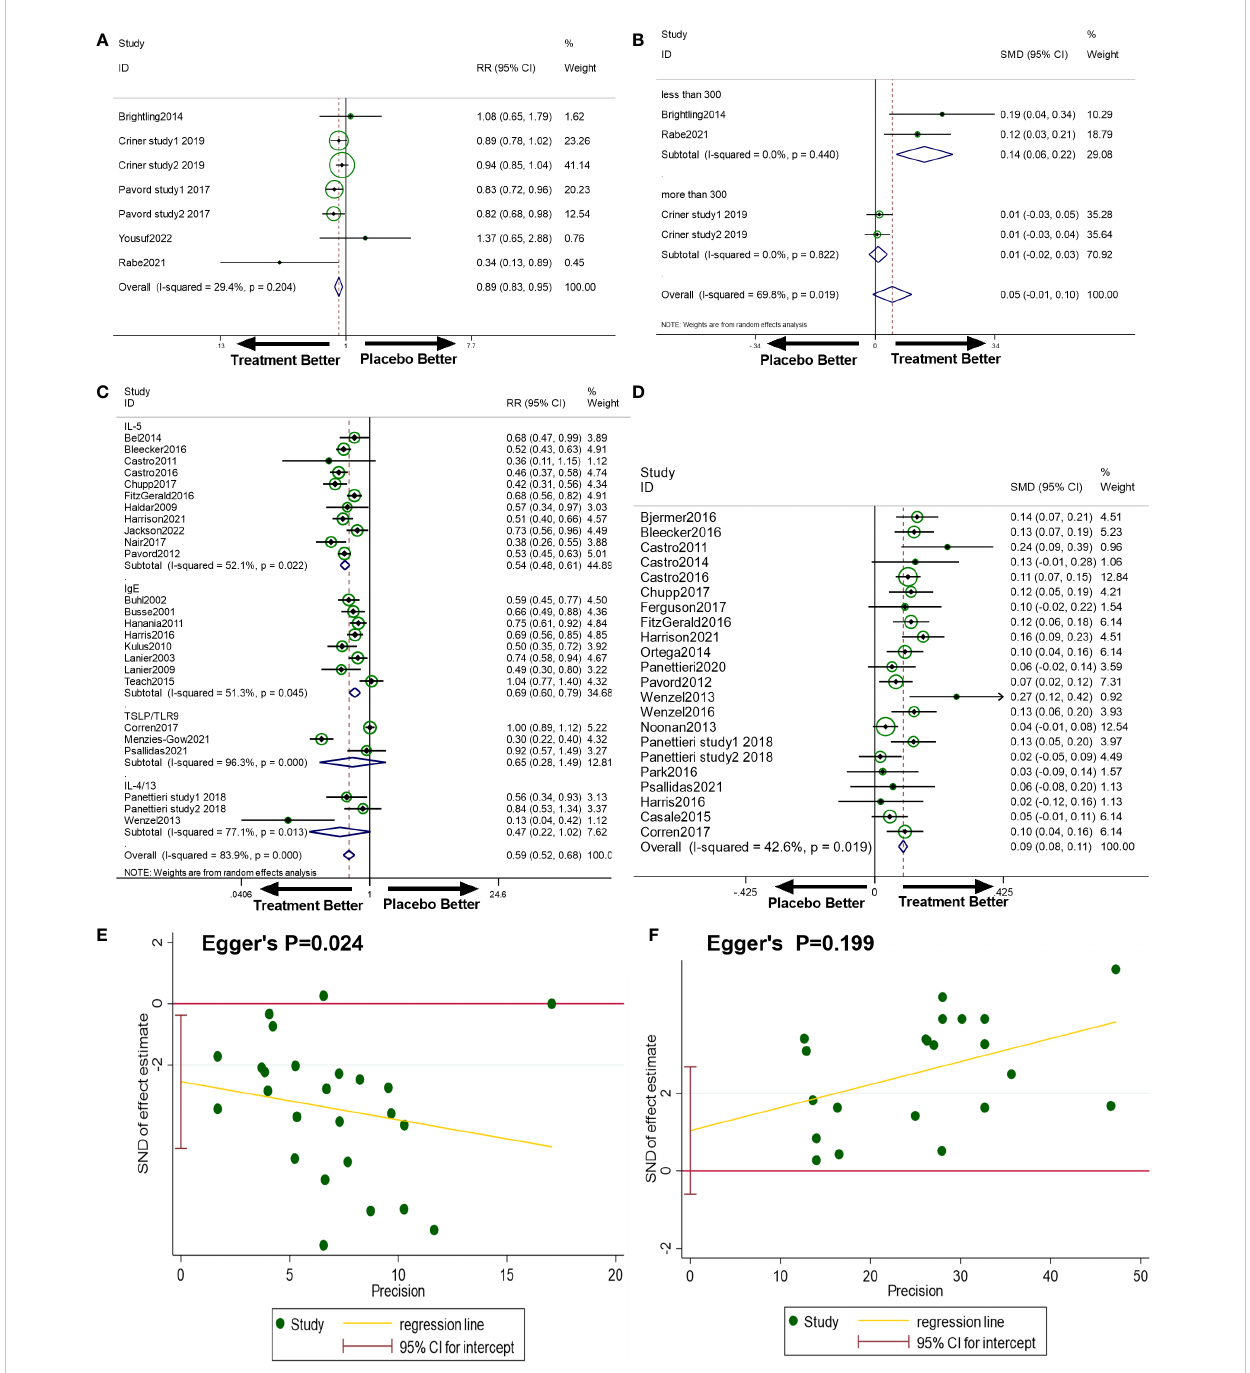
FIGURE 2 (A) The effect of anti-T2s versus placebo on exacerbation rate in COPD. Fixed-effect model. (B) The effect of anti-T2s versus placebo on FEV1 change from baseline in COPD. Random-effect model. (C) The effect of anti-T2s versus placebo on exacerbation rate in asthma. Random-effect model. (D) The effect of anti-T2s versus placebo on FEV1 change from baseline in asthma. Fixed-effect model. (E) Egger ’ s test of exacerbation rate in asthma in the meta-analysis. (F) Egger ’ s test of FEV1 in asthma in the meta-analysis. CI , con fi dence interval; SMD, standard mean difference; RR, rate